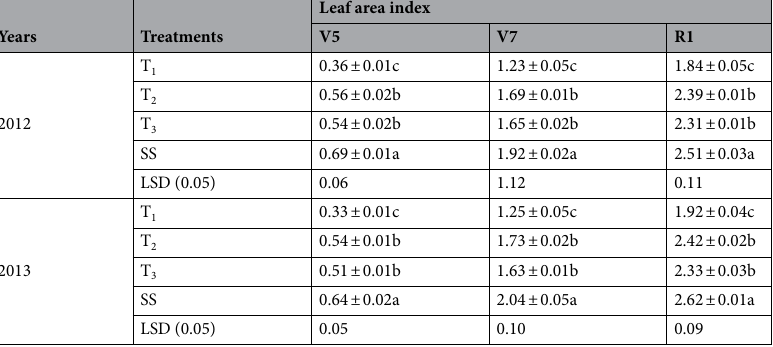
Table 2. Effect of different strip-width treatments on leaf area index of soybean at fifth trifoliate stage (V5), seventh trifoliate stage (V7), and flower initiation stage (R1) in cropping seasons from 2012 to 2013. Treatment codes represent narrow-strips (T 1 , 180 cm); medium-strips (T 2 , 200 cm); and wide-strips (T 3 , 220 cm) in maize/soybean relay intercropping system. SS is the sole cropping system of soybean. Means are averages over three replicates ± standard error of the mean. Means that do not share the same letters in a column differ significantly at p ≤ 0.05 using least significant differences, calculated separately for each